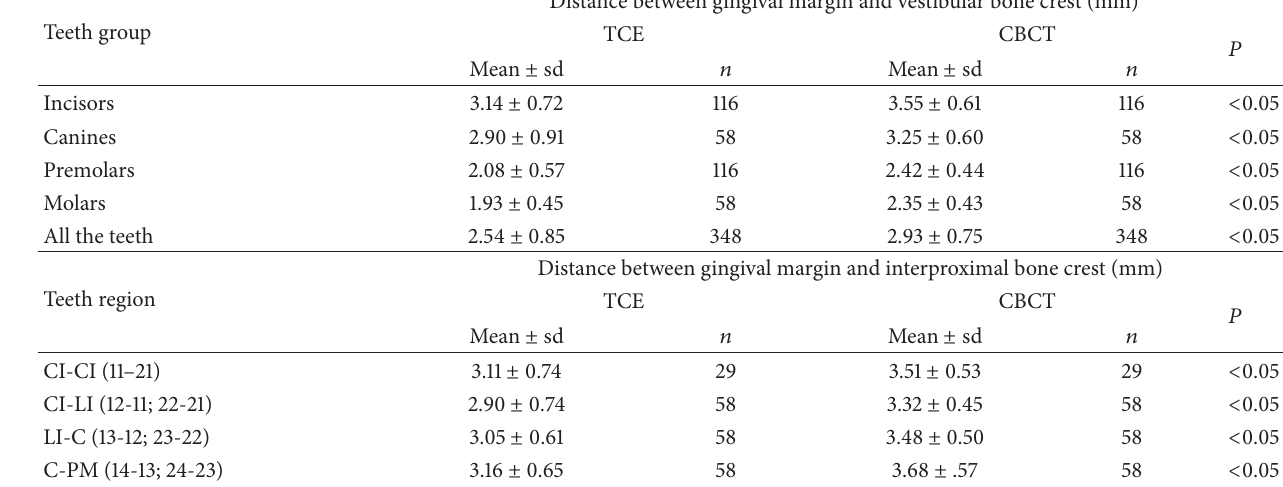
Table 2: Mean and standard deviation (sd) of distance between the gingival margin and vestibular bone crests (GMBC-V) gingival margin and interproximal bone crests (GMBC-I) obtained by transsurgical clinical evaluation (TCE) and cone-beam computed tomography. Teeth